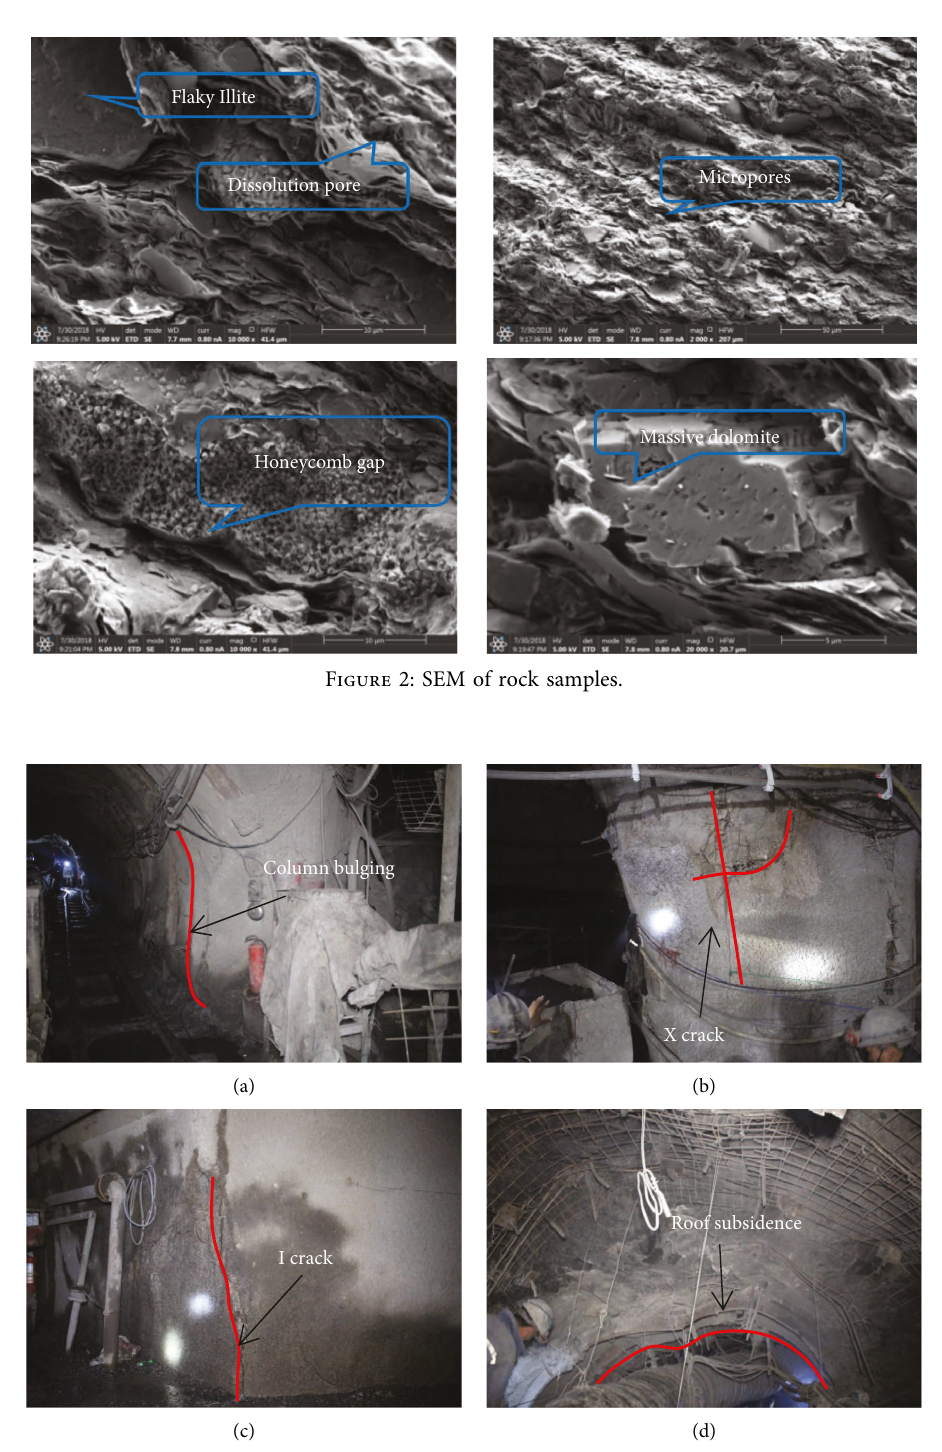
Figure 3: Deformation and failure characteristics. (a) Middle rock column bulging; (b) Type X crack; (c) Type I crack; (d) roof subsidence.